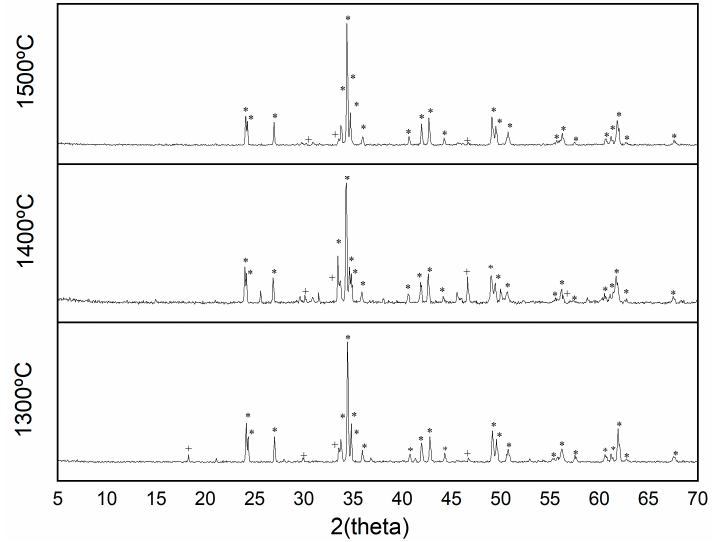
Figure 11. XRD pattern of pigment Y 0.98 Al 0.98 Cr 0.04 O 3 fired at different temperatures 1300 °C; 1400 °C; 1500 °C (+ garnet Y 3 Al 5 O 12 phase; * perovskite YAlO 3 phase).